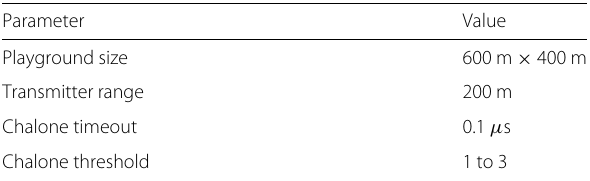
Table 8 Simulation parameters for experiments in ideal